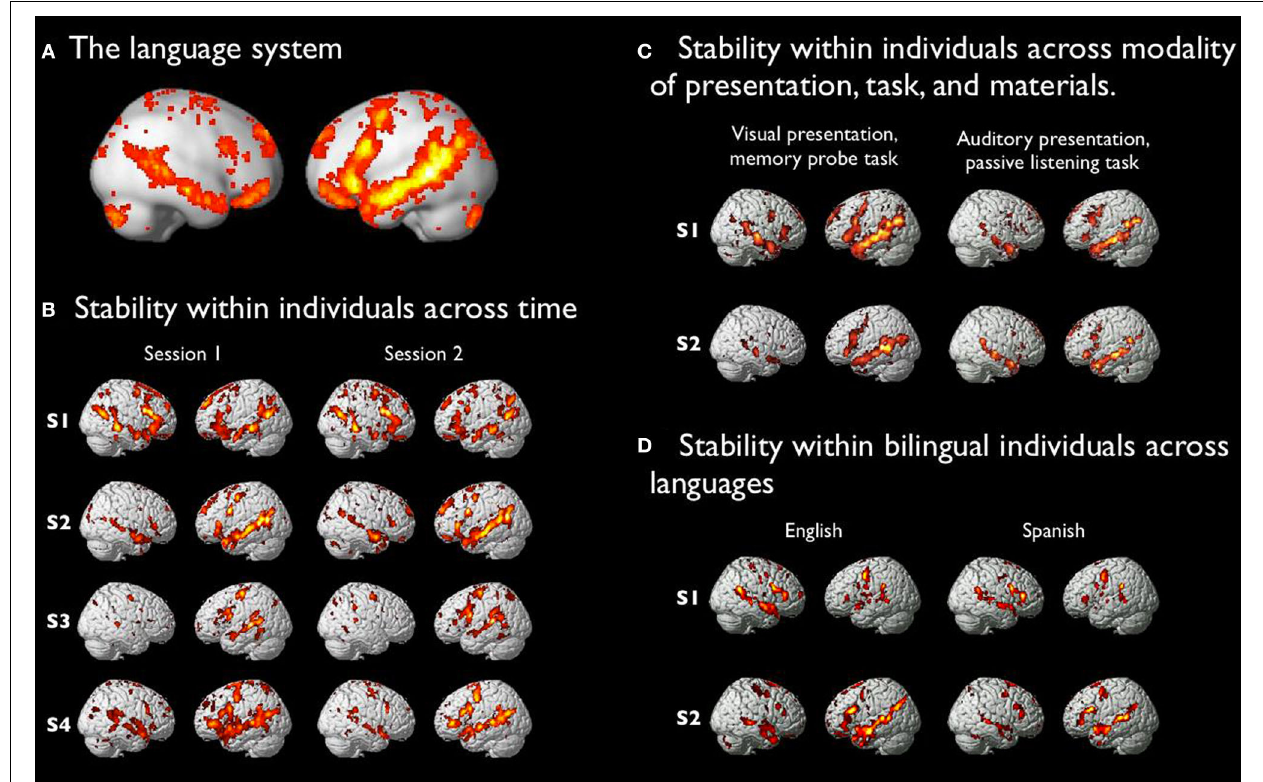
FIGURE 1 | (A) Thelanguagesystem:asetofbrainregionsthatarerobustlyand consistently activated by linguistic input (see (Fedorenko and Thompson-Schill, 2014); Fedorenko and Thompson-Schill, for further discussion of how to define the “language system/network”). A probabilistic activation overlap map for the contrast between sentences and sequences of pseudowords (adapted from Fedorenko et al., 2010). Warmer colors indicate greater proportions of subjects showing a reliable sentences > pseudoword lists effect. (B) Activation maps for four sample subjects tested on the sentences > pseudoword lists contrast across two independent scanning sessions, between 1 and 6.5 months apart. (For subjects 2 and 4, non-overlapping sets of materials were used across the